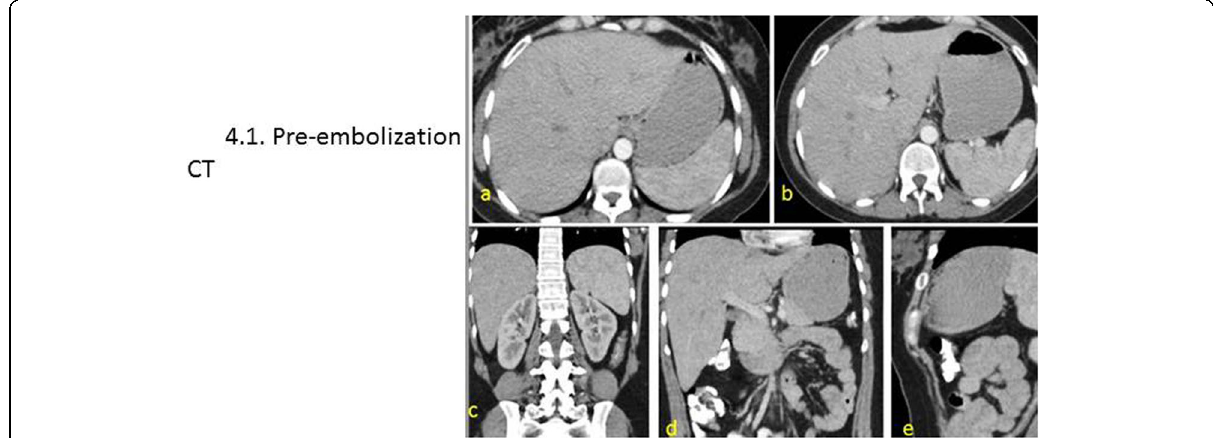
Fig. 7 Female patient, 45 years old, complaining of bleeding tendency and anemic manifestations. Pre embolization CT. Abdominal multislice CT examination post-contrast study. a , b Axial images. c , d Coronal images. e Sagittal images at the portovenous phase showing mild